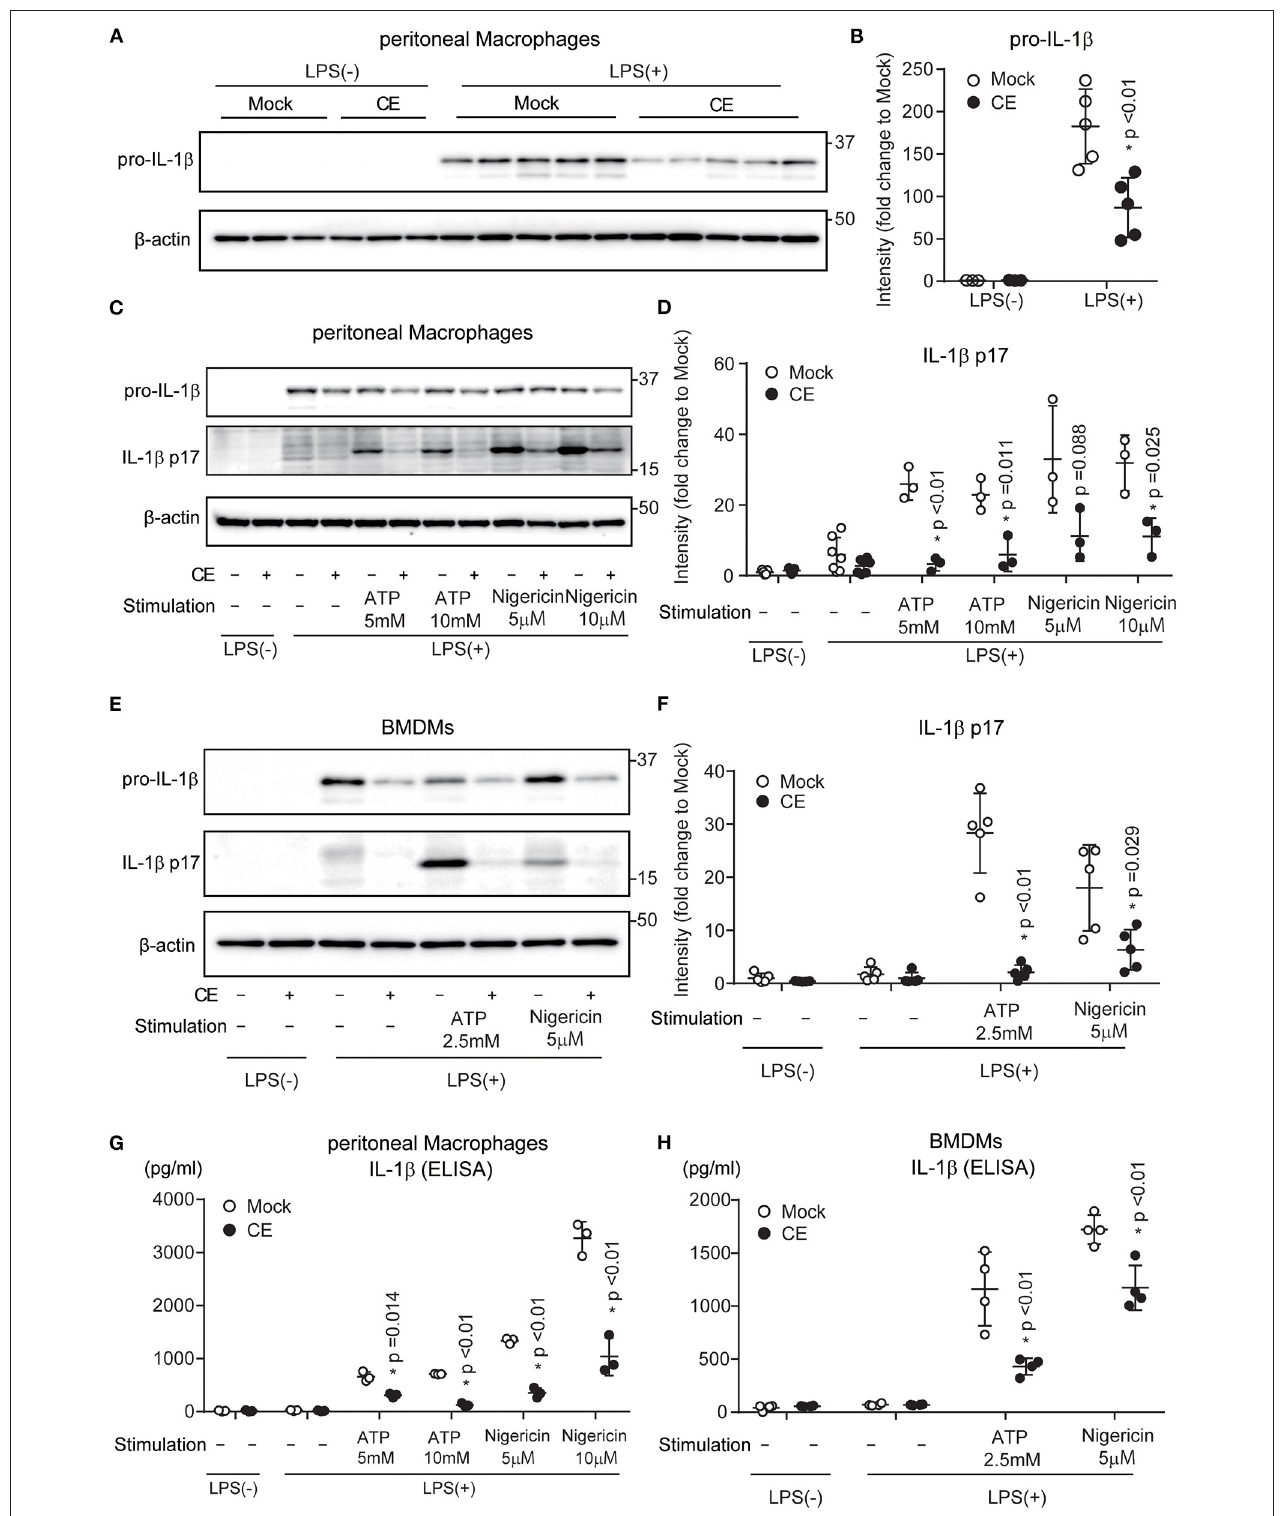
FIGURE 2 | Chlorella extract inhibits IL-1 β secretion in murine macrophages. (A,B) pMACs were treated with Mock or CE for 16h before being stimulated with 100ng/mL LPS for 4h. (C–H) pMACs and BMDMs were treated with Mock or CE for 16h prior to the addition of 100 (C,D,G) or 10 (E,F,H) ng/mL LPS for 4h